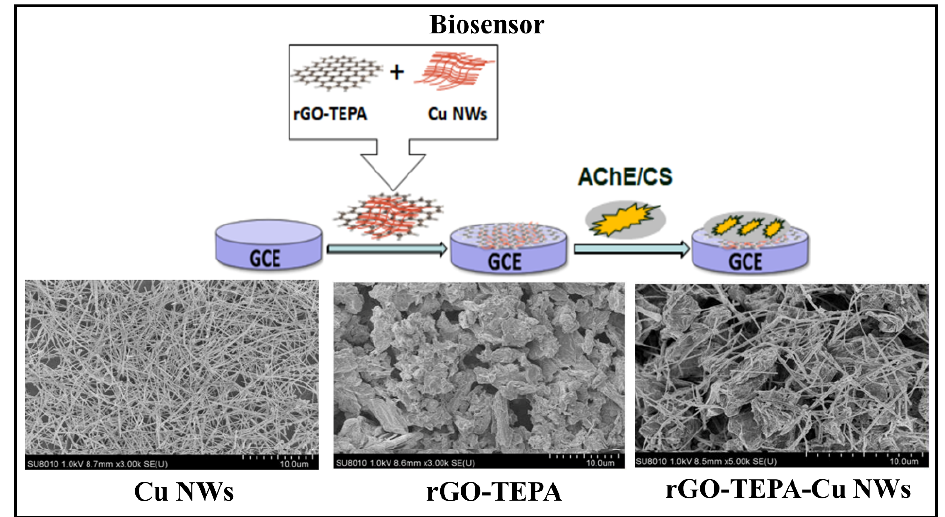
Figure 7. Fabrication of AChE-Cs/rGO-TEPA-Cu NWs/GCE biosensor and SEM images CuNWs, rGO-TEPA and rGO-TEPA-CuNWs. Reproduced with permission from Li et al. [70] Copyright 2020, ESG (open access journal).